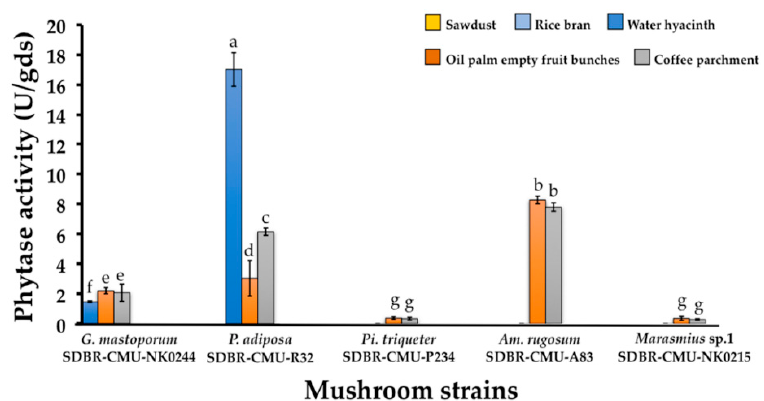
Figure 2. Phytase production during SSF using different agricultural residues by five selected mushroom strains. Five different substrates were tested but only three substrates were found to display phytase activity. The results are means ± SD . Different letters above each bar in the same parameter indicate the significant difference ( p < 0 . 05 ) .